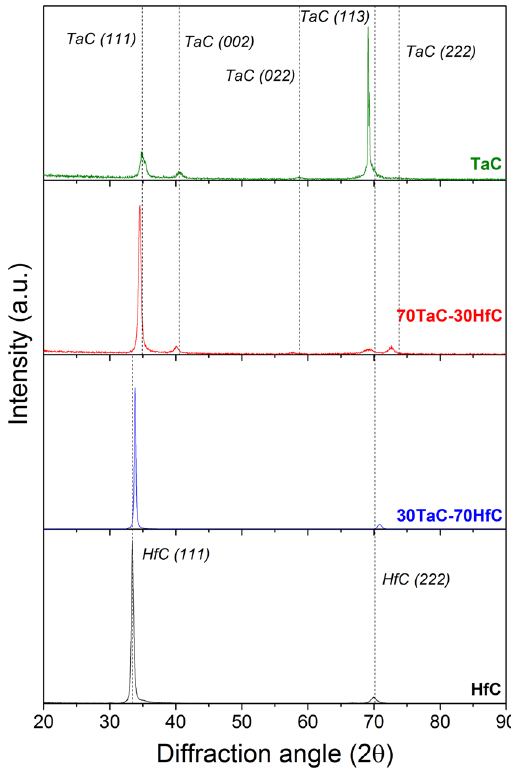
Figure 4. XRD patterns for the Ta-Hf-C deposited alloy films.